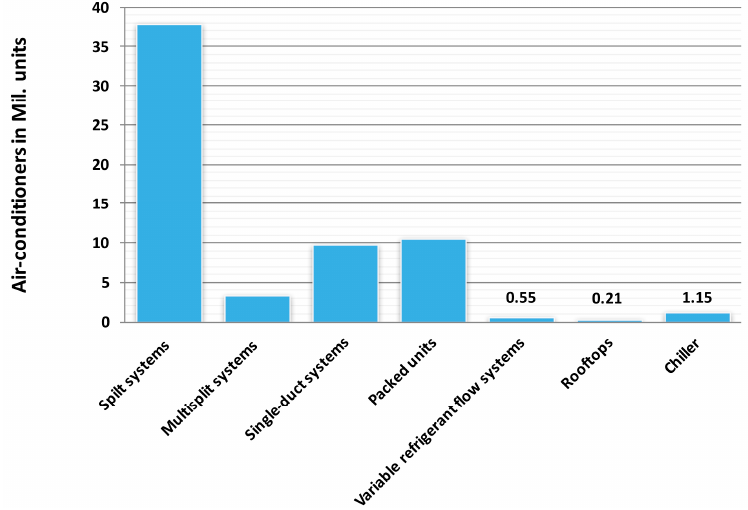
Figure 10. Number of operative units per AC type, EU15 (see references in the Appendix A, Table A3). Split systems account for the majority of AC units per type with more than 30 million (Mil.)